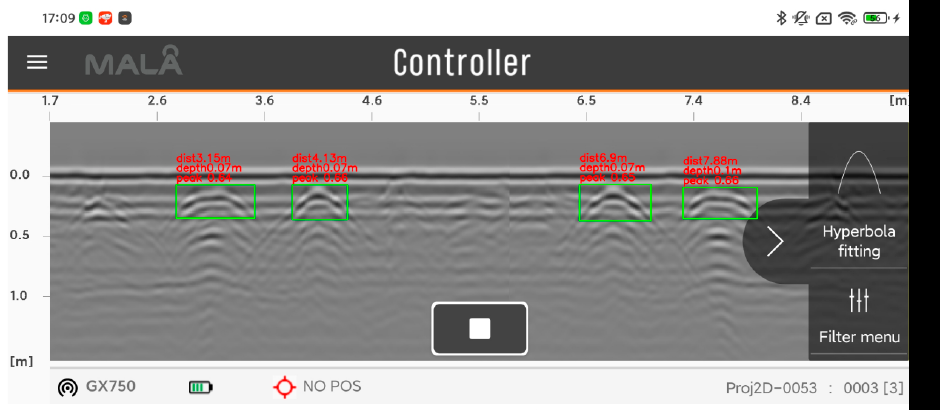
Figure 14. Buried depth and displacement position map obtained by linear interpolation.